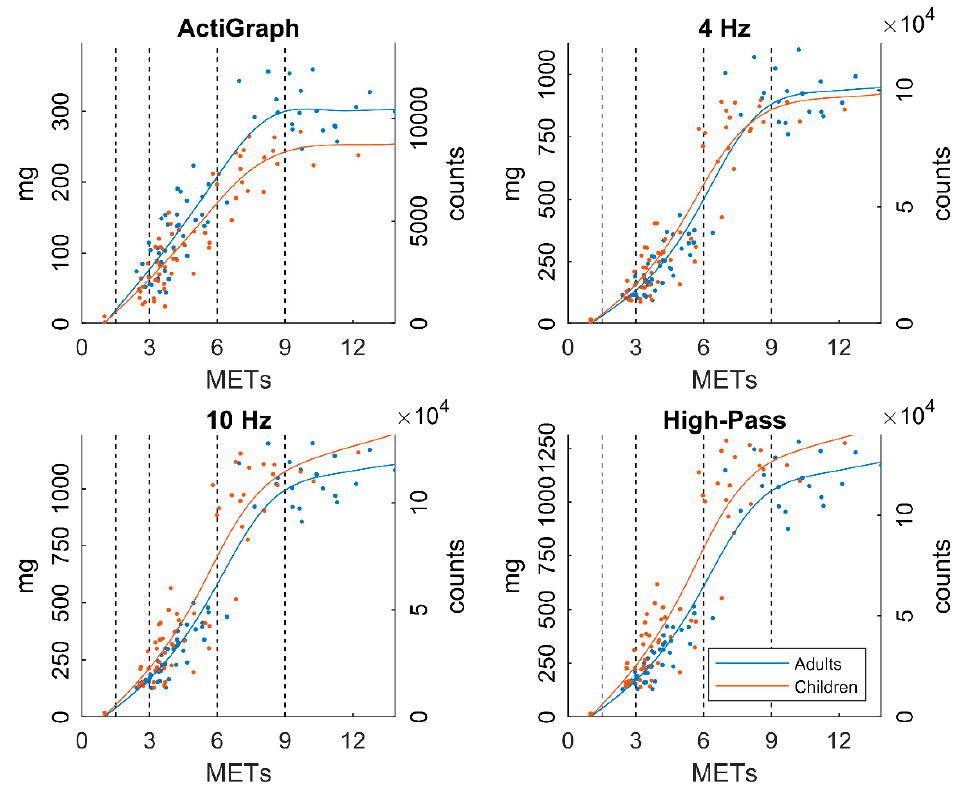
Figure 2. MET values plotted against acceleration output (mg, counts) using different filters for all locomotion speeds and subjects as well as fitted smoothing splines. Dotted lines represent cut-points at 1.5 (LPA), 3 (MPA), 6 (VPA), and 9 (VVPA) METs, respectively.